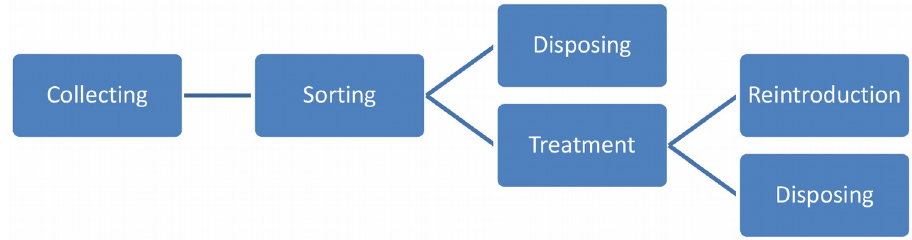
Figure 3. Reverse chain